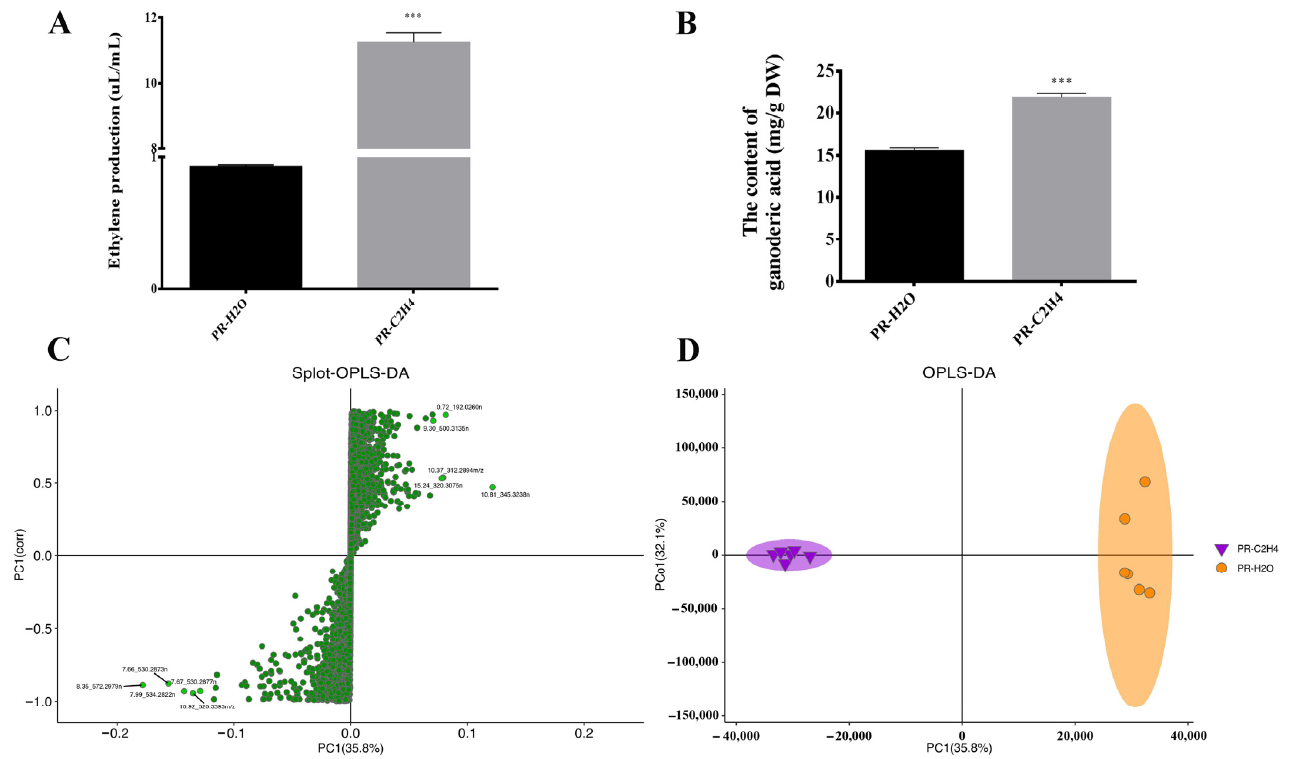
Figure 1. Overview of ethylene production and metabolites of G. lucidum. ( A , B ) are the ethylene production and the content of ganoderic acid of G. lucidum . The histograms marked with *** represent significant differences according to ANOVAs; it indicates statistical significance ( p < 0.001) compared to the control. PR-H 2 O and PR-C 2 H 4 represent the primordia of G. lucidum treated with water and ethylene, respectively. ( C , D ) are the Splot-OPLS-DA and OPLS-DA analysis of different samples.